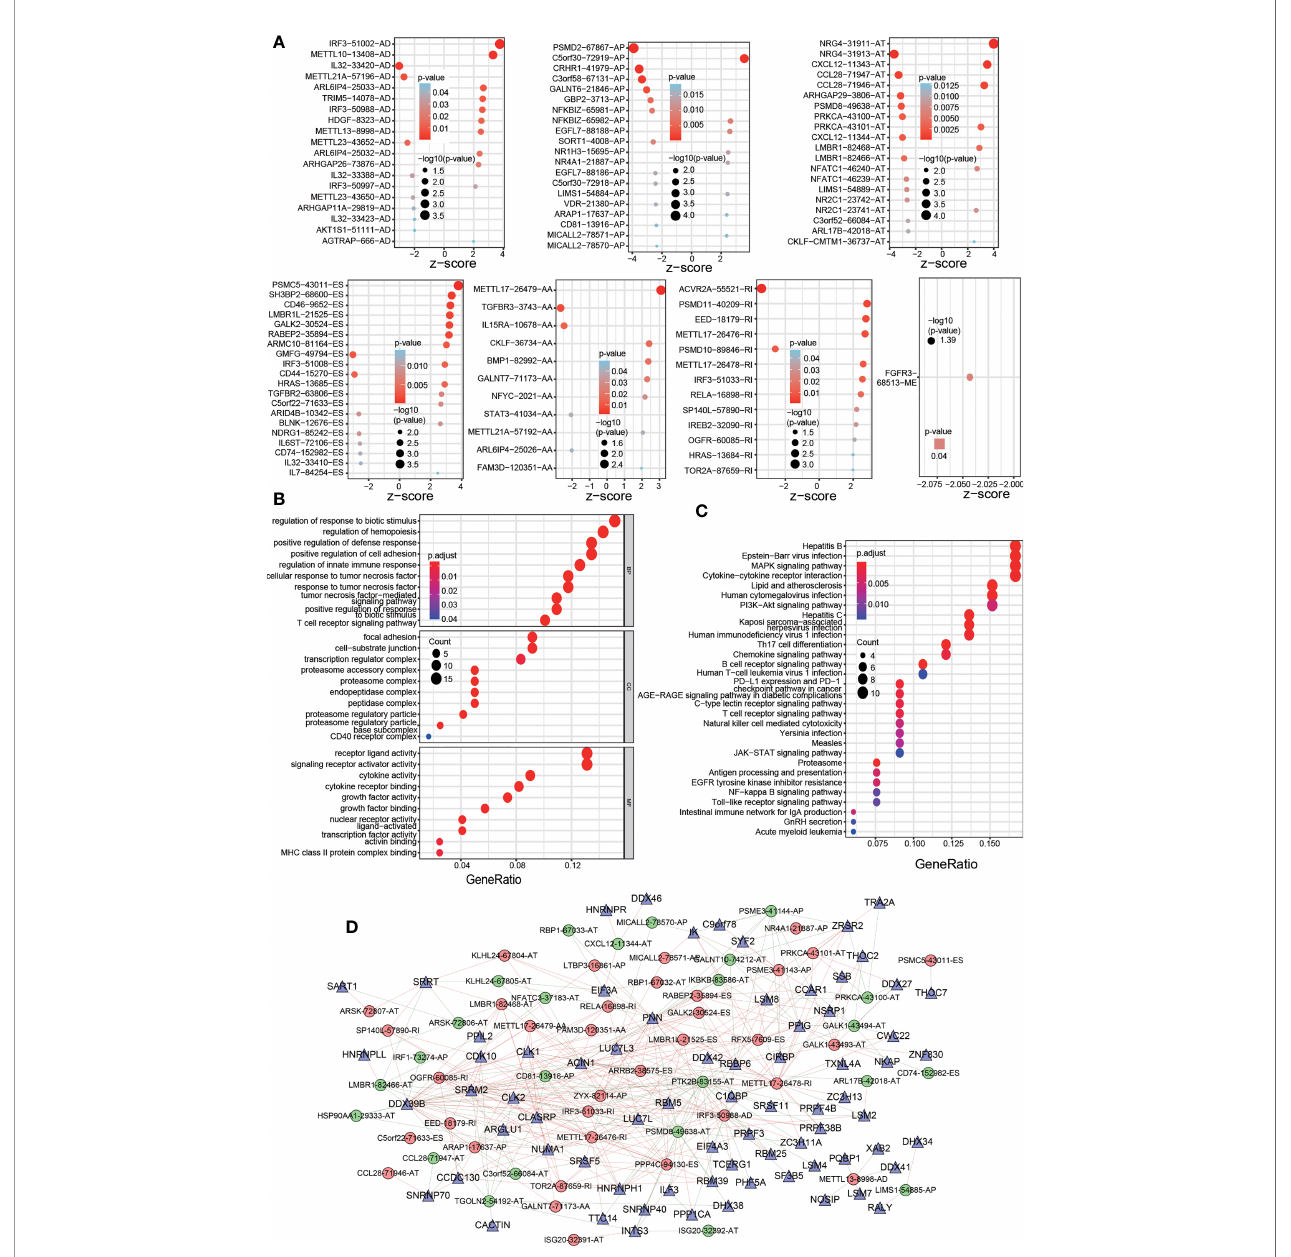
FIGURE 2 | Signi fi cant OS-ASEs in colon cancer and their characteristics. (A) Bubble plots of the top 20 most signi fi cant OS-ASEs correlated with clinical outcome based on type (AA, AD, AP, AT, ES, ME and RI). GO (B) and KEGG pathway (C) analyses of OS-ASEs. (D) The SF-AS regulatory network. In the network, high-risk and low-risk OS-ASEs are represented by red and green circles, respectively, and SFs are represented by triangles. The red and green lines indicate positive and negative regulation,